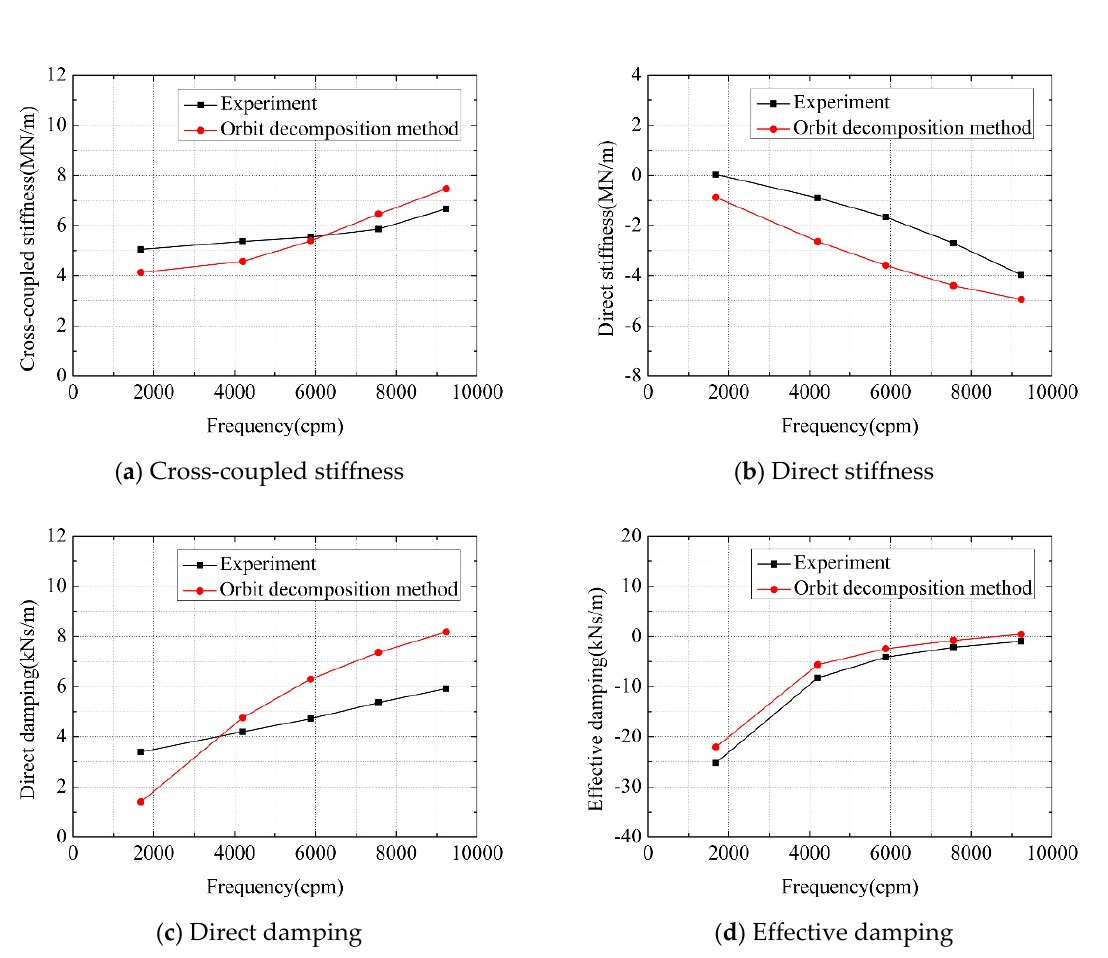
Figure 18. Comparison of rotordynamic coefficients with the measured data. Figure 18d depicts the effective damping versus whirl frequency. The predicted and measured results are in good agreement. The effective damping increases with the whirl